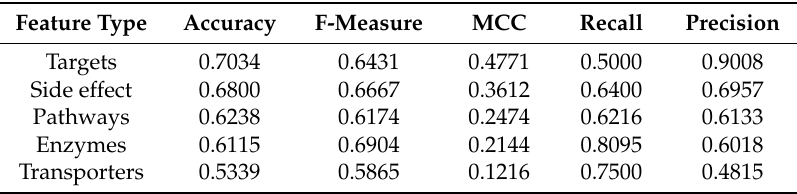
Table 2. Performance comparison of prediction models based on different feature types using the improved naïve Bayesian algorithm on the independent data